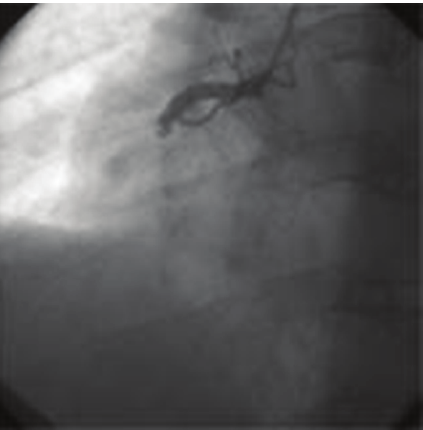
Figure 1: Occluded right coronary artery by trombi. Figure 2: Occluded left circumflex coronary artery by